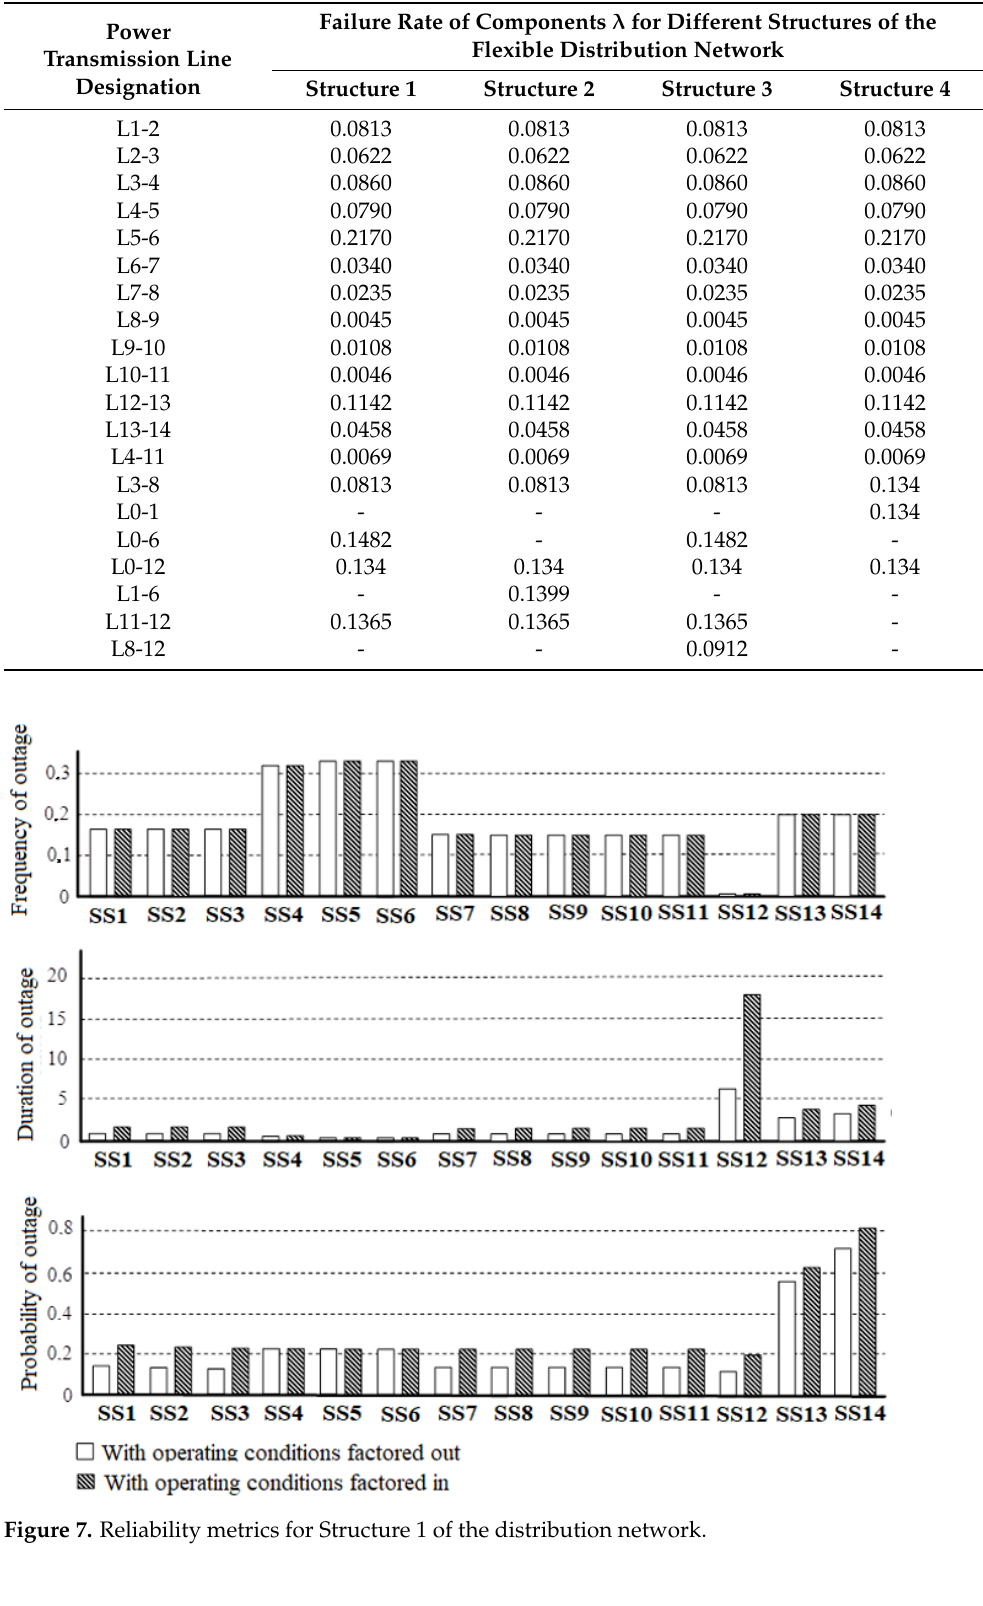
Table 2. Failure rate of components (for power transmission lines).